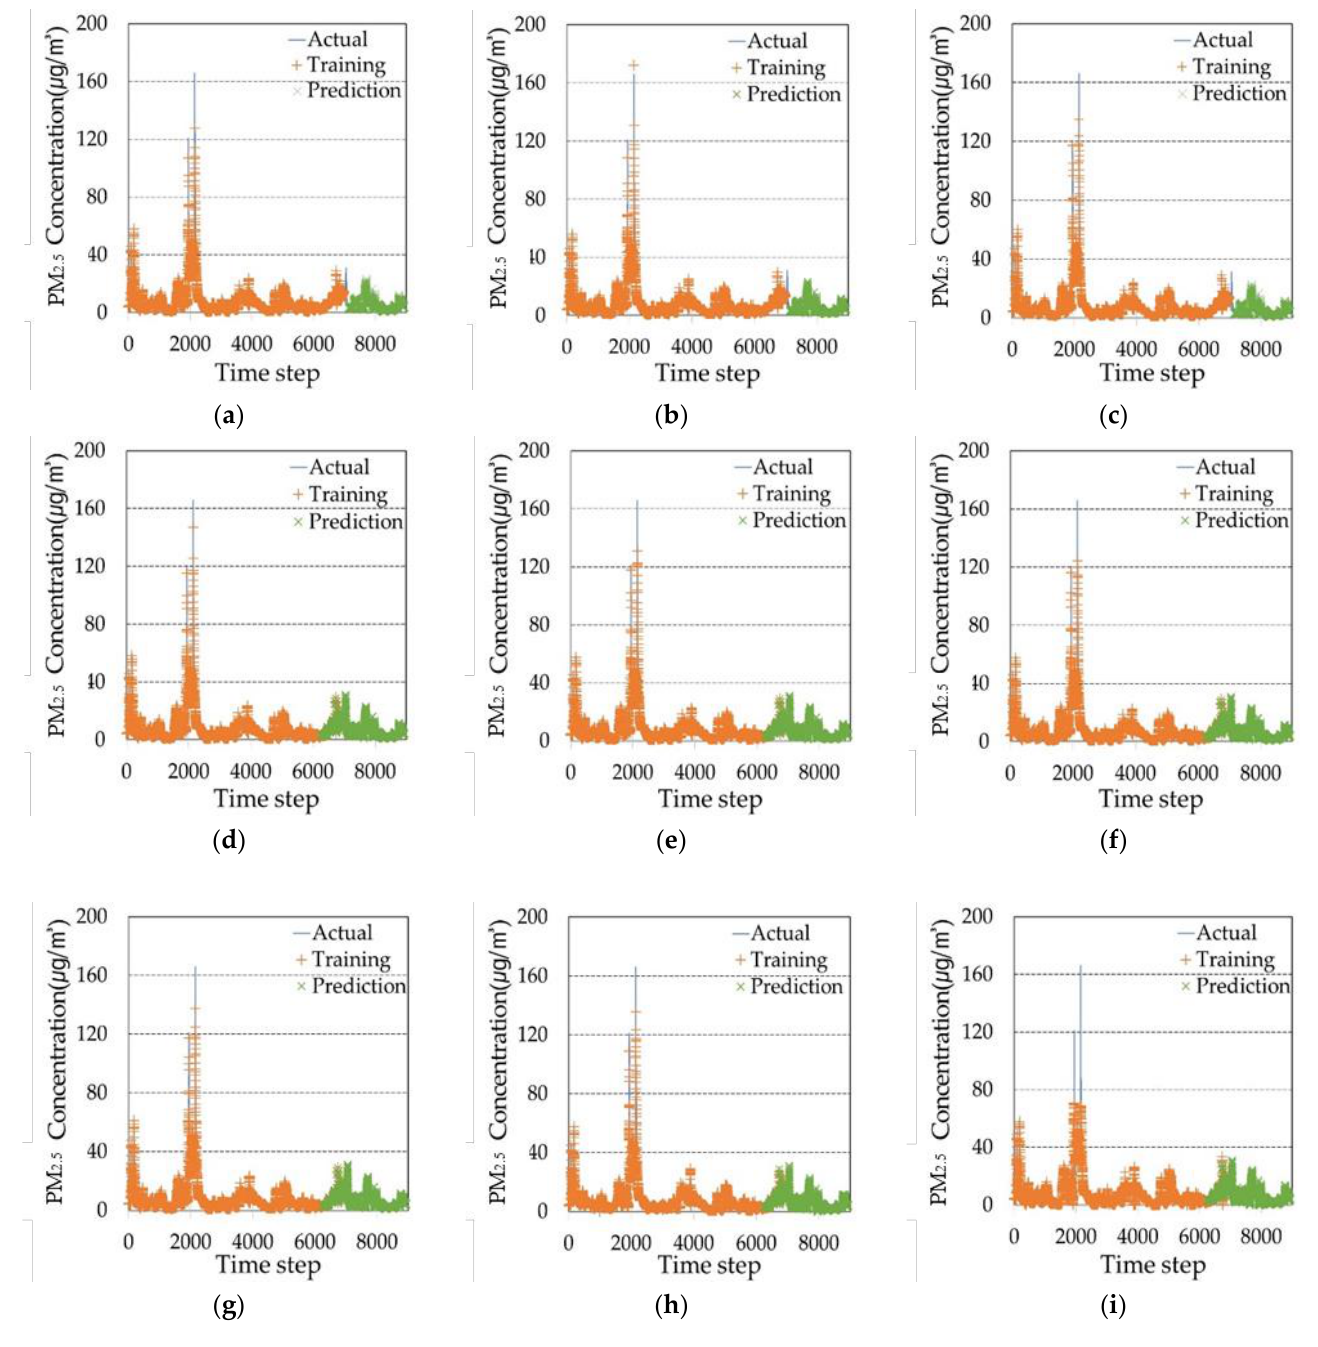
Figure 5. Prediction results of PM 2.5 concentration. ( a ) LM-Hidden layer-1; ( b ) LM-Hidden layer-3; ( c ) LM-Hidden layer-5; ( d ) BR-Hidden layer-1; ( e ) BR-Hidden layer-3; ( f ) BR-Hidden layer-5; ( g ) BFG-Hidden layer-1; ( h ) BFG-Hidden layer-3; ( i ) BFG-Hidden layer-5.